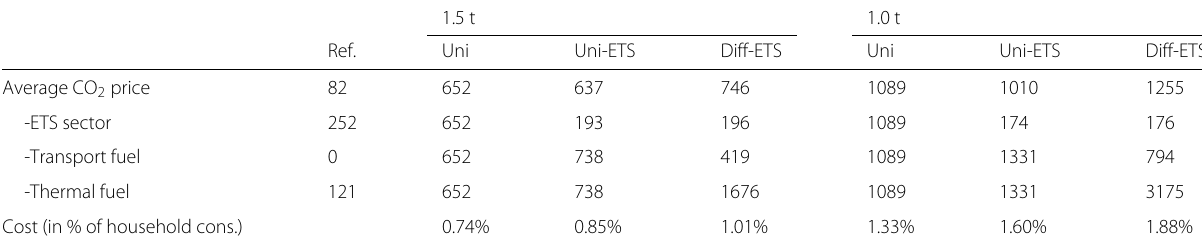
Table 3 CO 2 prices and welfare cost in